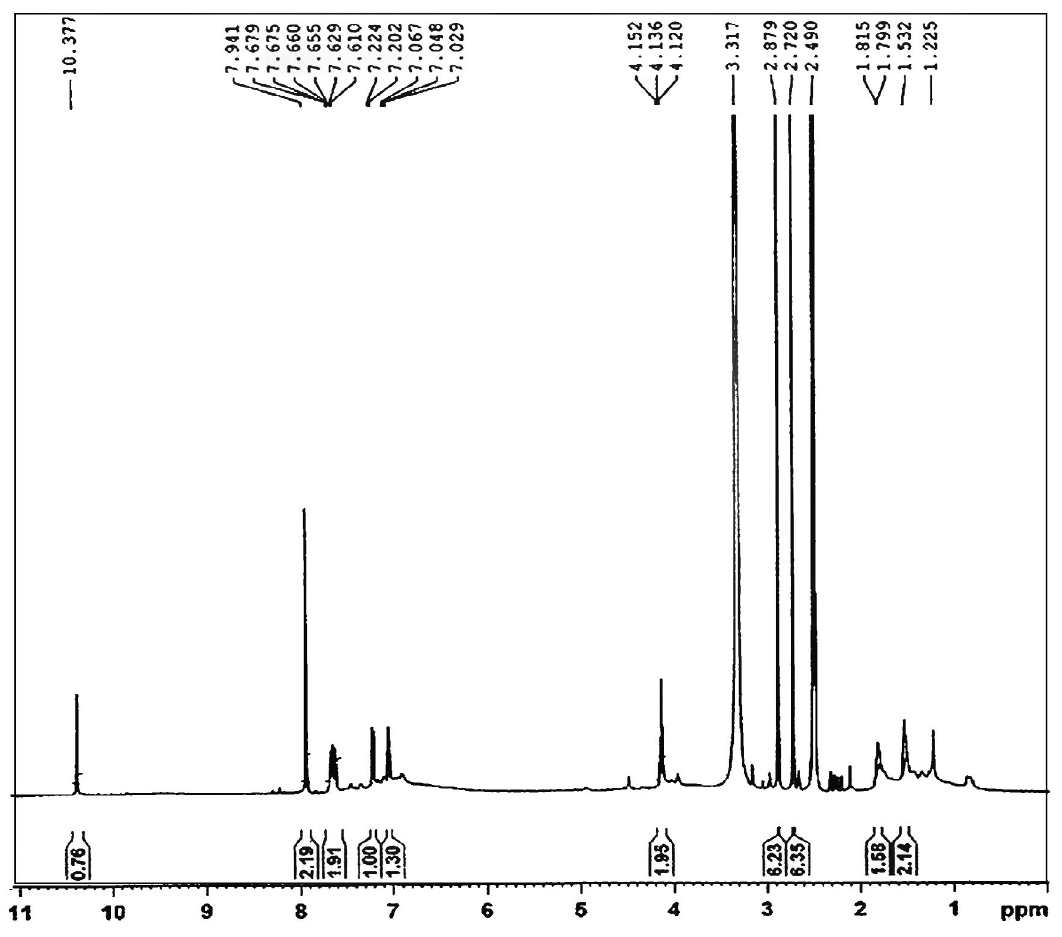
Figure 3 . 1 HNMR spectrum of polymer P o